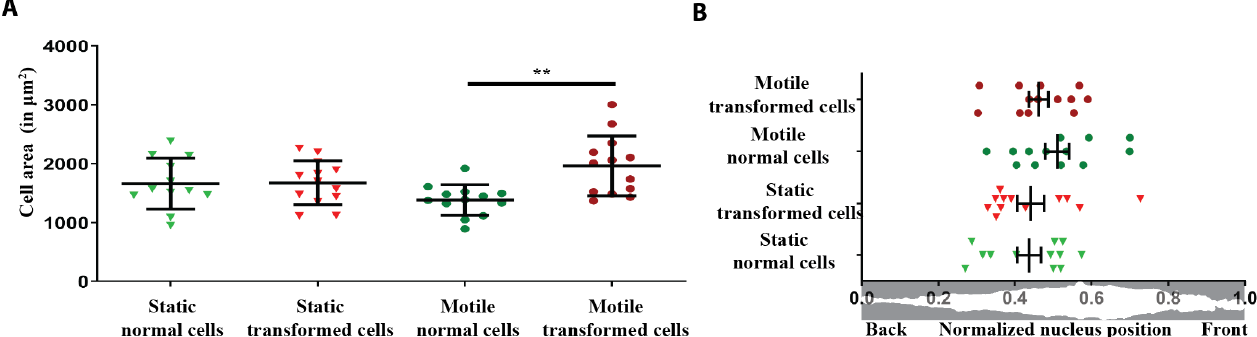
Figure 3. Cell area and position of nuclei in different conditions. ( A ) Measurement of total cell area in different conditions. Each point corresponds to the average area of one cell over 5 time points. ( B ) Location of nucleus with respect to normalized cell length. Each point corresponds to the average of the nucleus positions of one cell over 5 time points. Graphs represent mean ± SEM of 12 cells (in static) and 13 cells (in motile) from 1–4 independent experiments per condition. For each cell, the measurements at 5 different time points (0, 30, 60, 90, and 120 min) were averaged. For statistics, a two-tailed Student’s t -test with unequal variance was used (** p < 0.01).